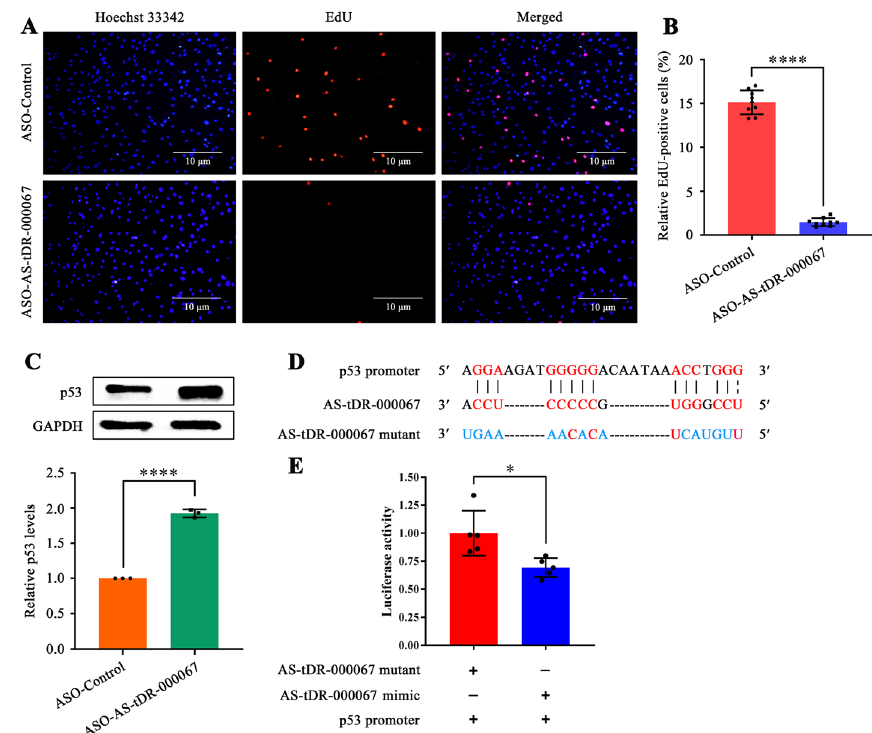
Fig. 4 AS‑tDR‑000067 suppression inhibits HASMC proliferation by elevating p53 levels. A EdU incorporation assay of HASMCs transfected with ASO‑Control or ASO‑AS‑tDR‑000067. Blue fluorescence (Hoechst 33342) indicates cell nuclei, while red fluorescence (EdU) represents HASMCs with DNA synthesis. Scale bar 10 µm; B Relative EdU‑positive HASMCs. Data expressed as the ratio of EdU‑positive HASMCs to total ones. Data shown as mean SD of at least three independent experiments, **** p < 0.0001 versus ASO‑Control group; C ± Western blot analysis of p53 in HASMCs transfected with ASO‑Control or ASO‑AS‑tDR‑000067, with GAPDH as control. Data shown as mean SD of three independent experiments, * p < 0.05 versus ASO‑Control group; ± D Schematic of binding sites of AS‑tDR‑000067 to p53 promoter; E Verification of p53 promoter as a target of AS‑tDR‑000067 utilizing the dual‑luciferase reporter gene assay. Data shown as mean SD of at least three ± independent experiments, * p <